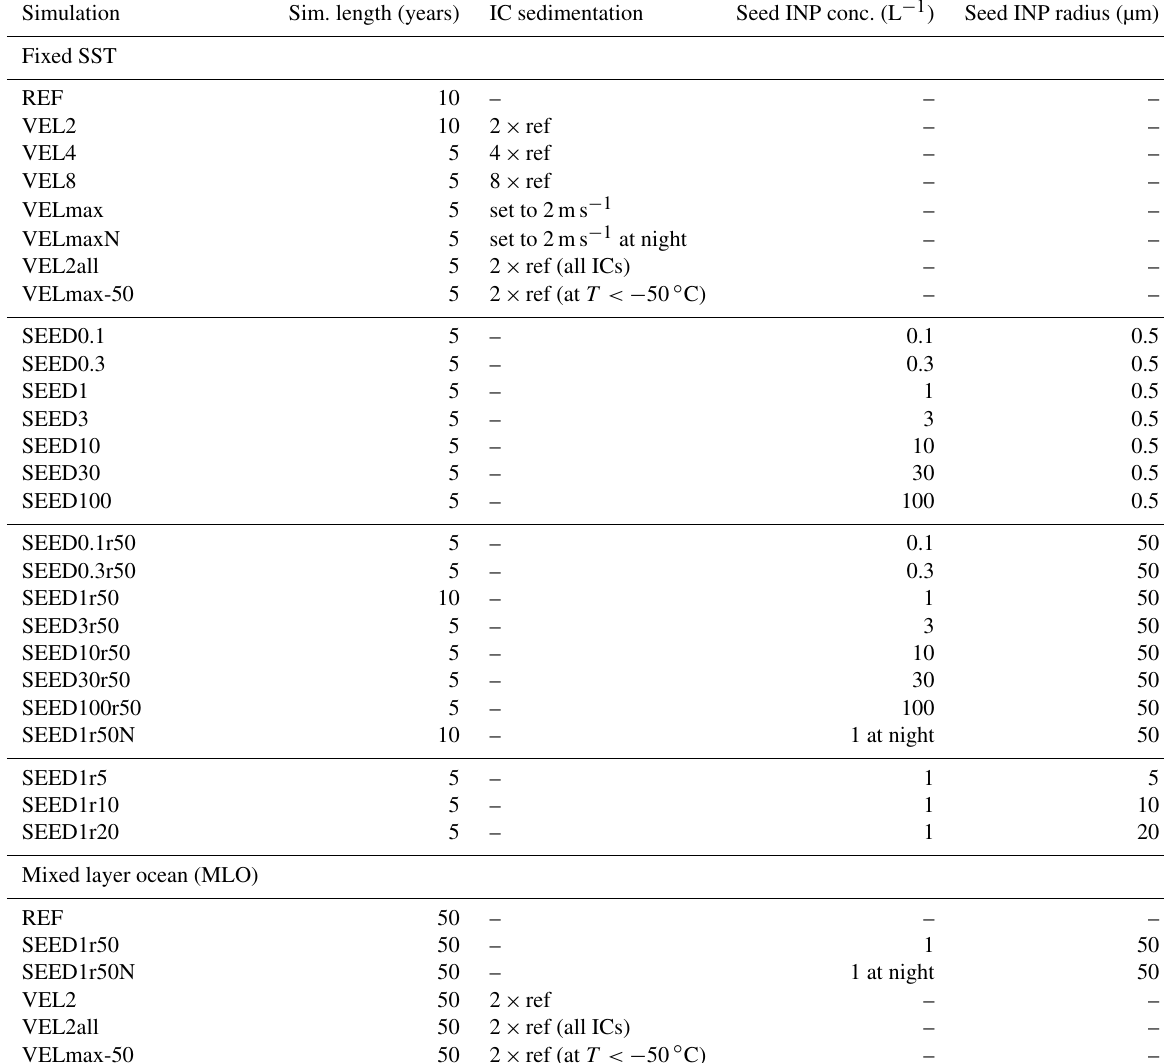
Table 1. Simulation terminology and respective cirrus geoengineering